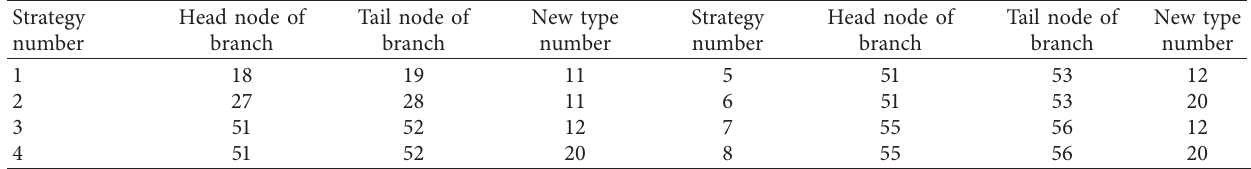
Table 3: Individual loss reduction strategies (distribution transformer).